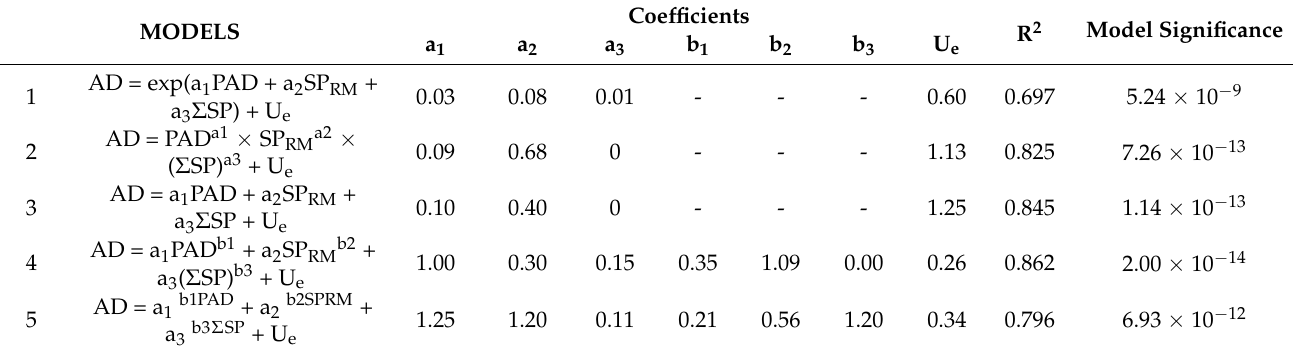
Table 8. Models functional laws, parameters and R 2 values and p